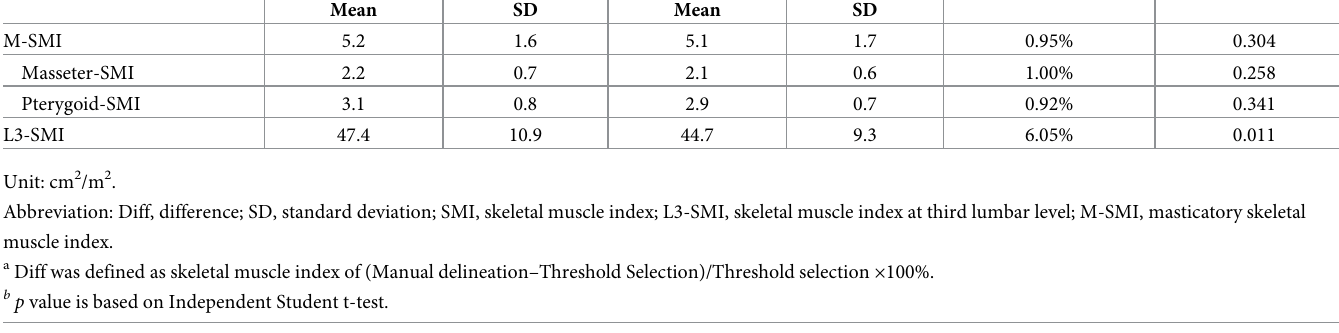
distributions, but the patients with HNC were primarily male ( p = 0.028) and significantly older than the patients with trauma ( p = 0.012). In addition, patients with HNC had signifi- cantly lower M-SMI and L3-SMI ( p = 0.011 and 0.03, respectively). Of the patients with HNC, 11 (21.2%) had cervical lymph node metastasis and more than half (n = 29, 55.8%) had stage III or IV disease. Tumor locations included the oral cavity (32 cases, 61.5%), hypopharynx (11 cases, 21.2%), oropharynx (6 cases, 11.5%), and larynx (3 cases, 5.8%). Table 2 presents the results of image analysis. Measurements of target skeletal muscles were accessible in all patients (S1 Appendix). High interobserver reliability between the two radiolo- gists was observed for both SMIs (ICC = 0.99 for the L3-SMI and ICC = 0.997 for the M-SMI, both p < 0.001). The M-SMIs were consistent between the manual delineation and threshold selection approaches (0.95%, p = 0.304, Table 2), whereas the manually delineated L3-SMIs were significantly overestimated compared with the threshold-selected L3-SMIs (6.05%, p = 0.011, Table 2). Because manual delineation resulted in these overestimated results, which may have been caused by muscle fattening, we used the M-SMI and L3-SMI obtained from threshold selection in subsequent analysis. Additional analyses revealed that differences in both the M-SMI and L3-SMI were nonsignificant between patients with early (stage I/II) and advanced (stage III/IV) stages. We could analyze the trauma and HNC groups as a single entity because no significant intergroup interaction was observed among these patients. Table 3 presents the regression